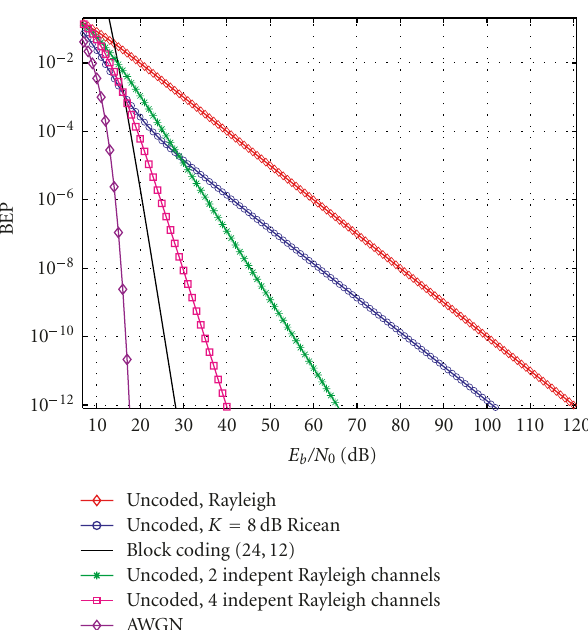
Figure 3: The required combined Tx-Rx antenna gain to achieve a target capacity.